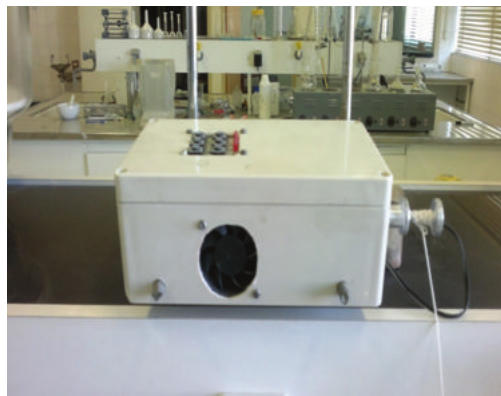
Figure 3: Custom-built apparatus for pulling up the substrate with constant speed in the lowering